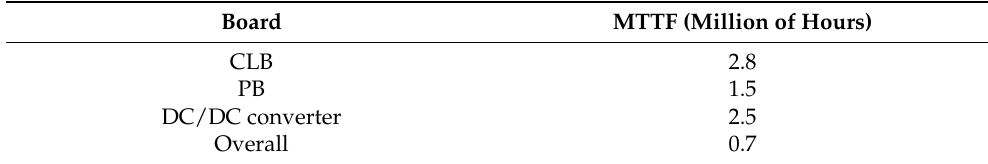
Table 1. Mean Time to Failure expressed in million of hours for CLB, PB and the main DC/DC converter within the DOM. These calculations mean if we would have one single DOM, it would have a failure every 0.7 million of